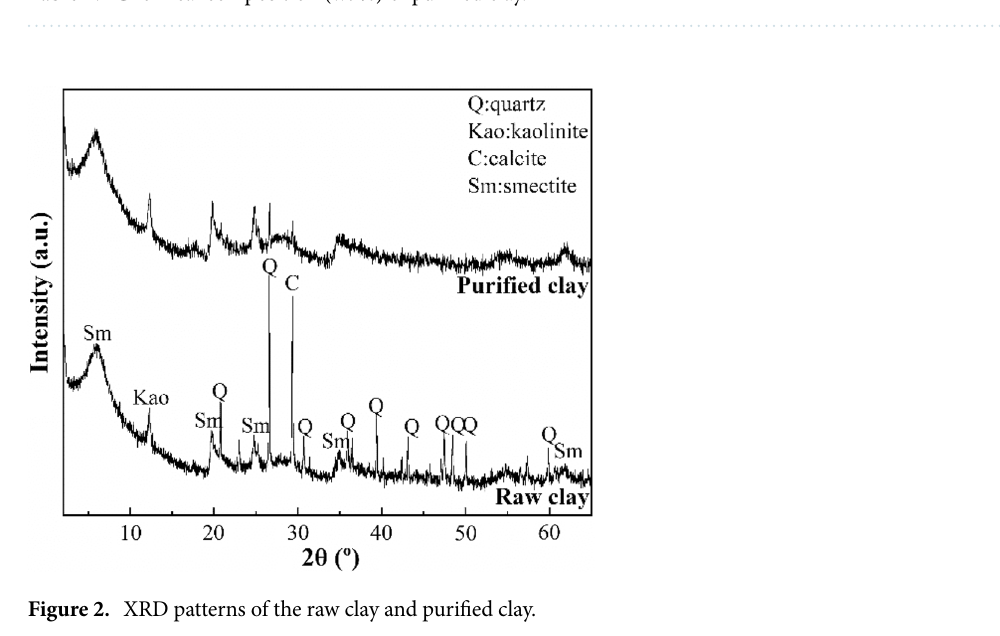
Table 2. Chemical composition (wt %) of purified clay.